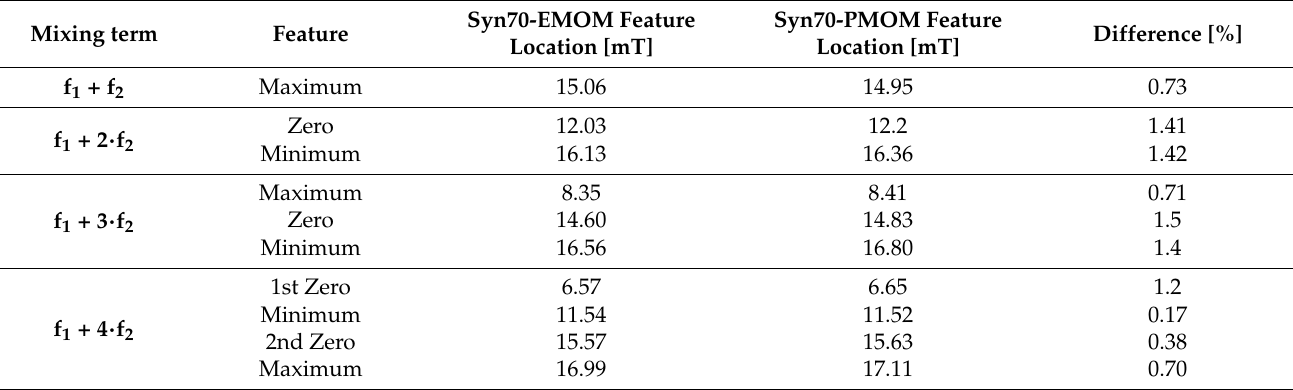
Figure 6. Nonlinear magnetic moment trace of sample Syn70 measured with EMOM − pulsed setup (black squares) over a field range of 0 to 24 mT and the PMOM setup (red circles) over a field range of 2 to 26.5 mT, for mixing harmonics f 1 + f 2 , f 1 + 2 · f 2 , f 1 + 3 · f 2 and f 1 + 4 · f 2 . Table 2. Comparison between the locations of the characteristic features of the sample Syn70 mea- sured with EMOM and PMOM